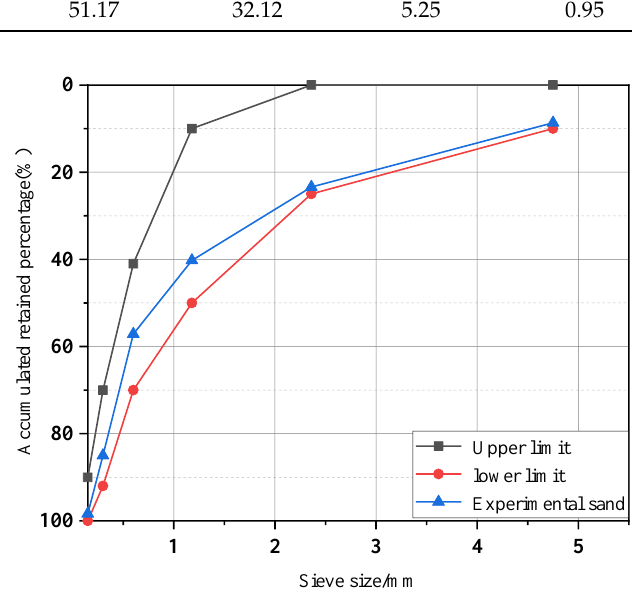
Figure 1. Screening curve of sand.